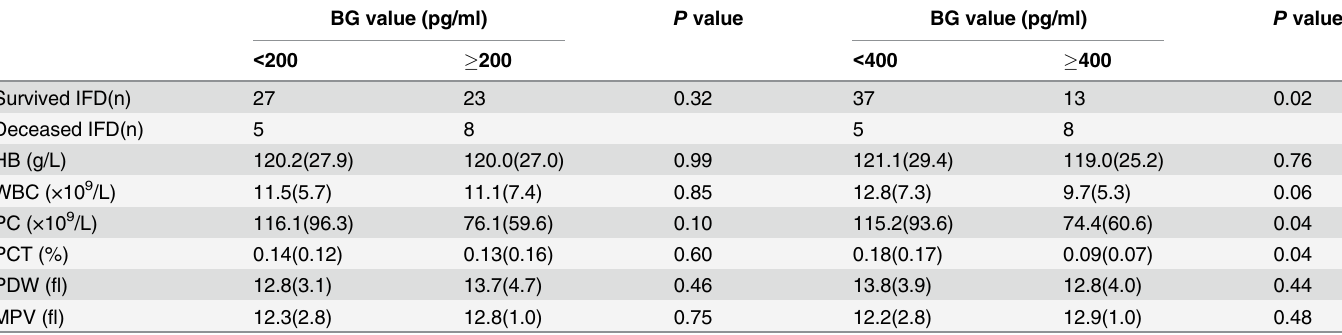
Table 5. Hematological parameters and mortality among infants in different BG value groups.